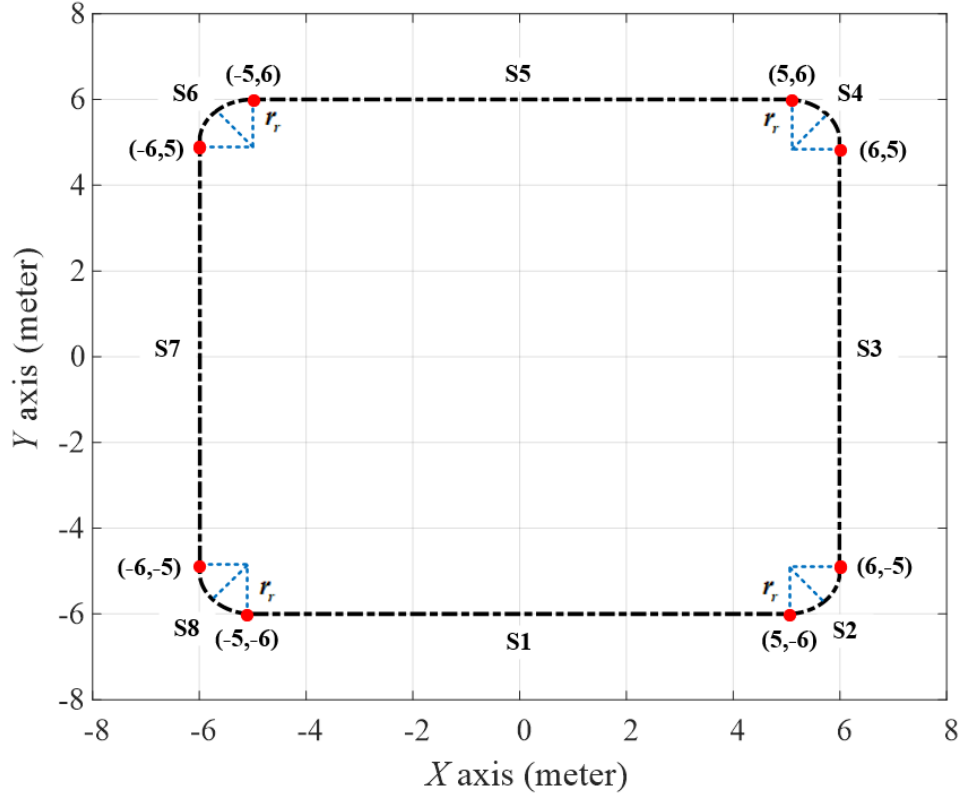
Figure 2. The desired square trajectory, with a radius of 6 m from x 0 = − 5 m, y 0 = − 6